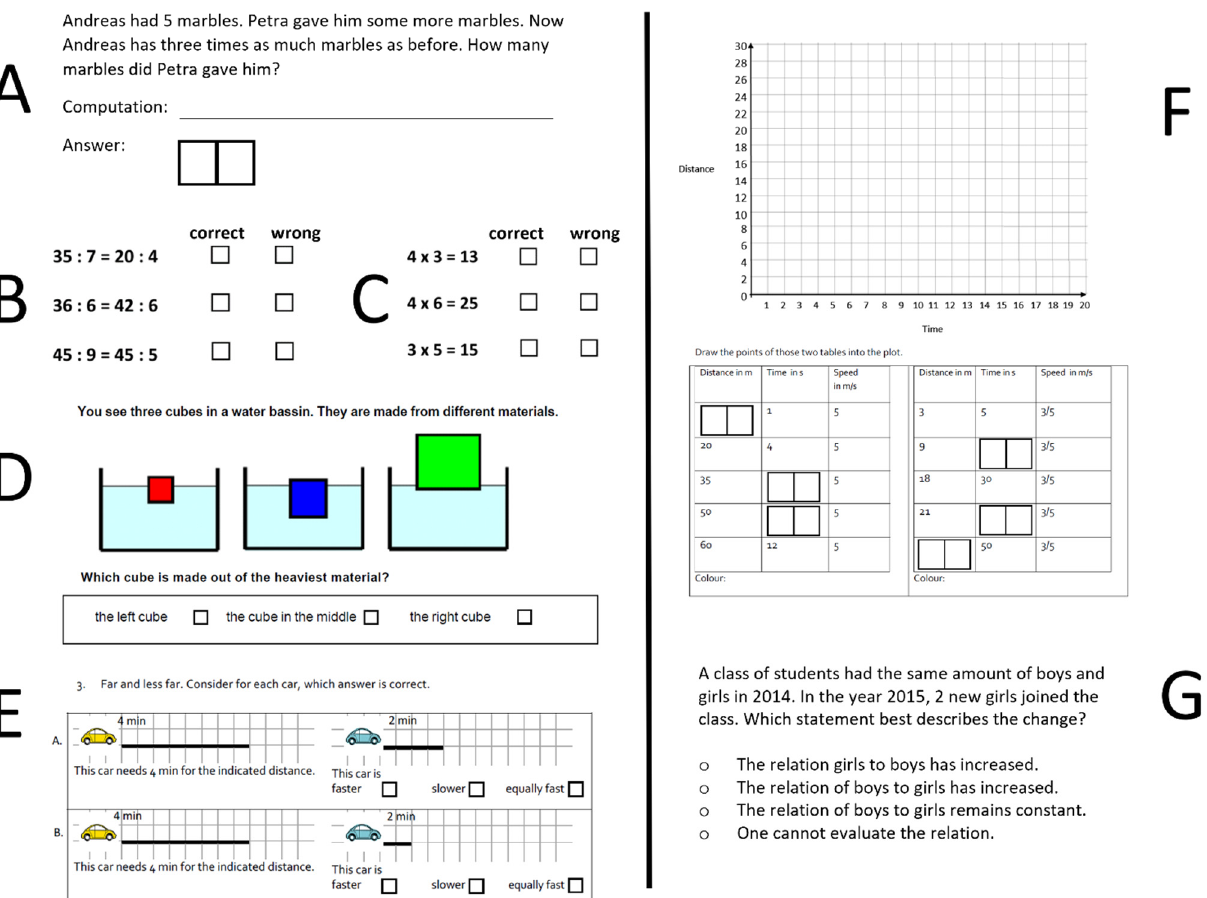
Figure A1. Example items of the measures in the pretest and posttest. ( A ) mathematical word problem; ( B ) division problems; ( C ) multiplication problems; ( D ) concept test on density; ( E ) concept test on speed; ( F ) manipulation check: table and Cartesian coordinate system for a proportional relation in the context of speed; ( G ) advanced proportional reasoning test. Note : The test material is available on https://osf.io/9tz3c/ (except the intelligence measure due to copyright reasons).